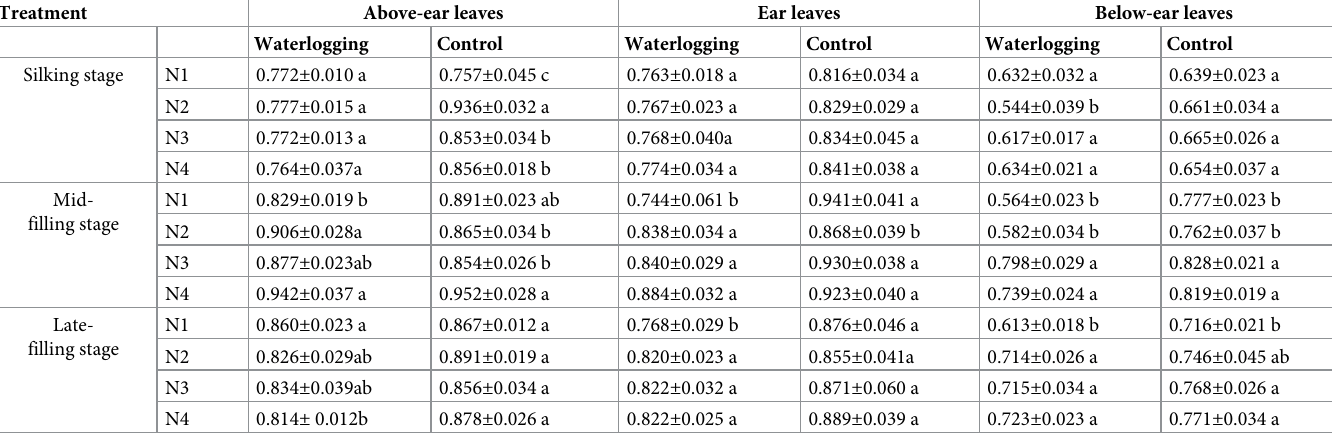
Table 4. Effects of different N treatments on the photochemical quenching of variable chlorophyll fluorescence (qP) (2015).